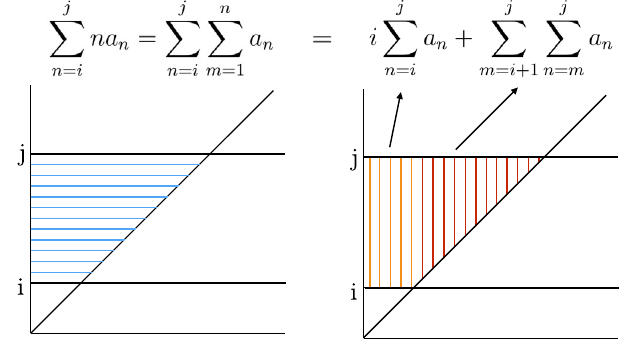
FIG. 11. Illustration of the identity